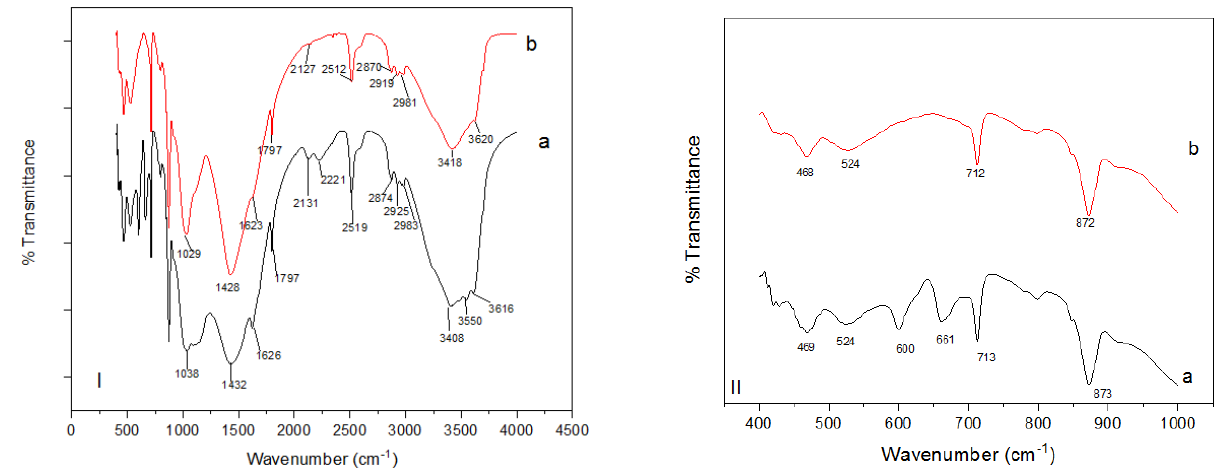
Figure 2. FTIR spectrum (400 – 4000 cm – 1 ( I ) and 400 – 1000 cm – 1 ( II )) of raw (a) and lead-loaded (b) Odaracha powder. Table 1. Physicochemical Property of Odaracha Soil. Chemical Property